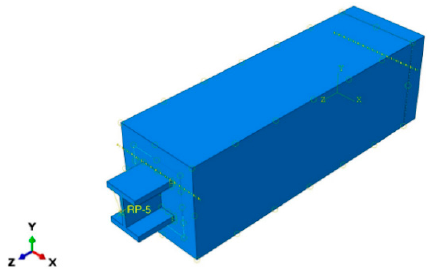
Figure 9. Specimen containing section steel and RAC.